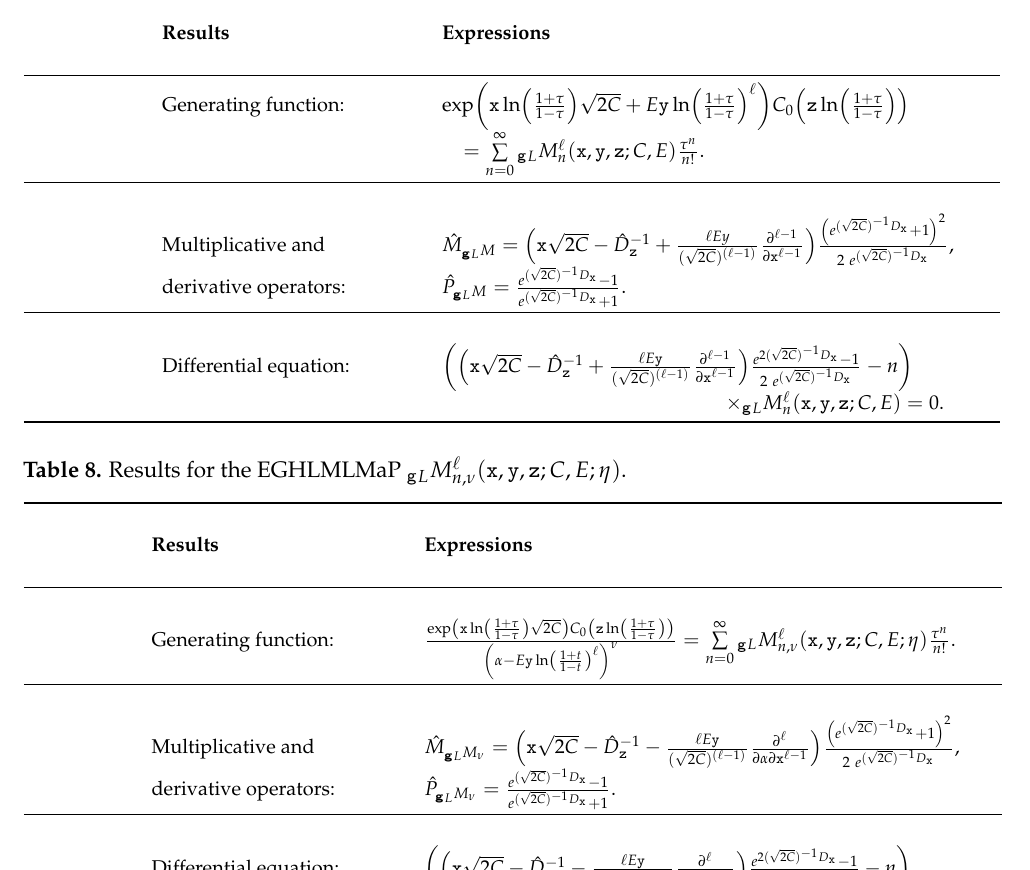
Table 7. Results for the GHLMLMaP g L M (cid:96) n ( x , y , z ; C , E ) . Results